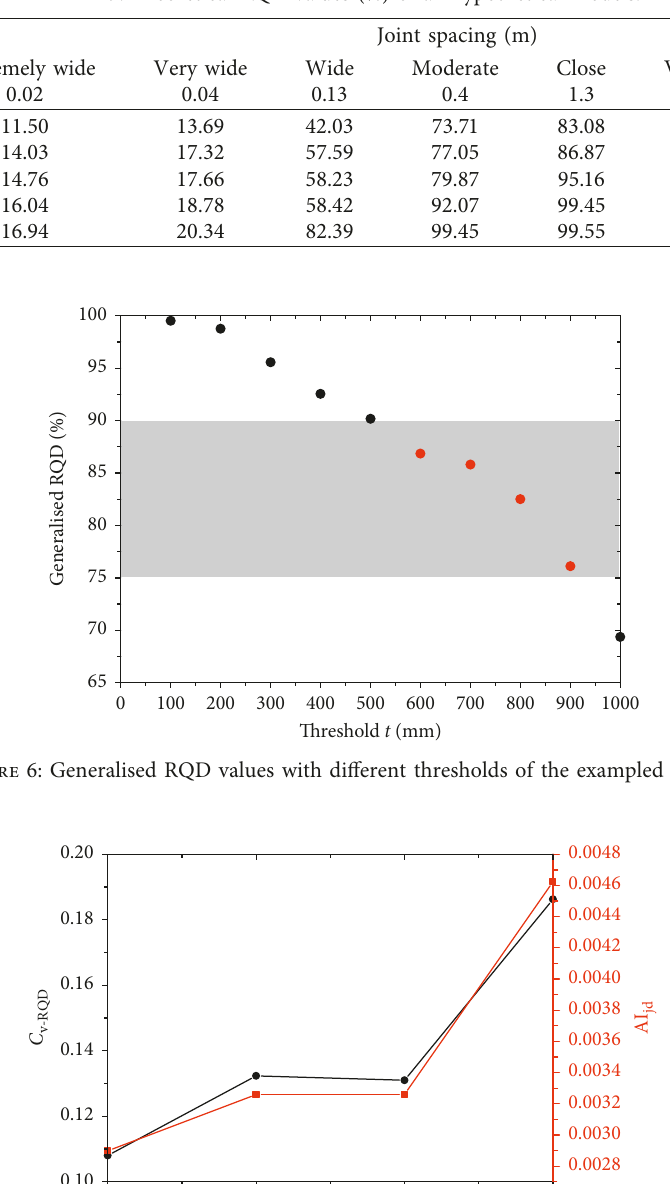
Table 7: Theoretical RQD values (%) of all hypothetical models.